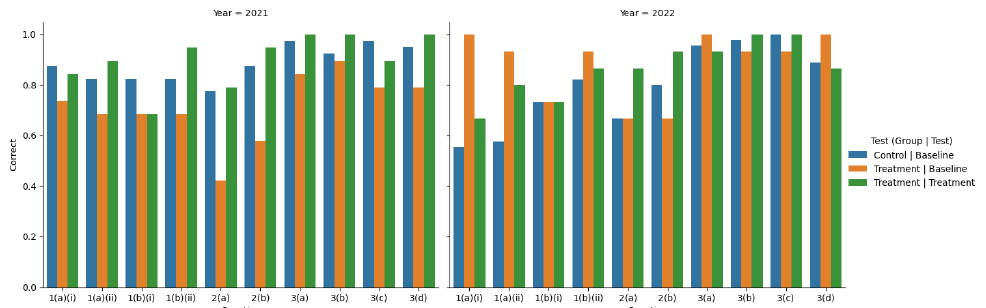
Figure 6. Distribution of scores by year, according to the groups and tests taken.